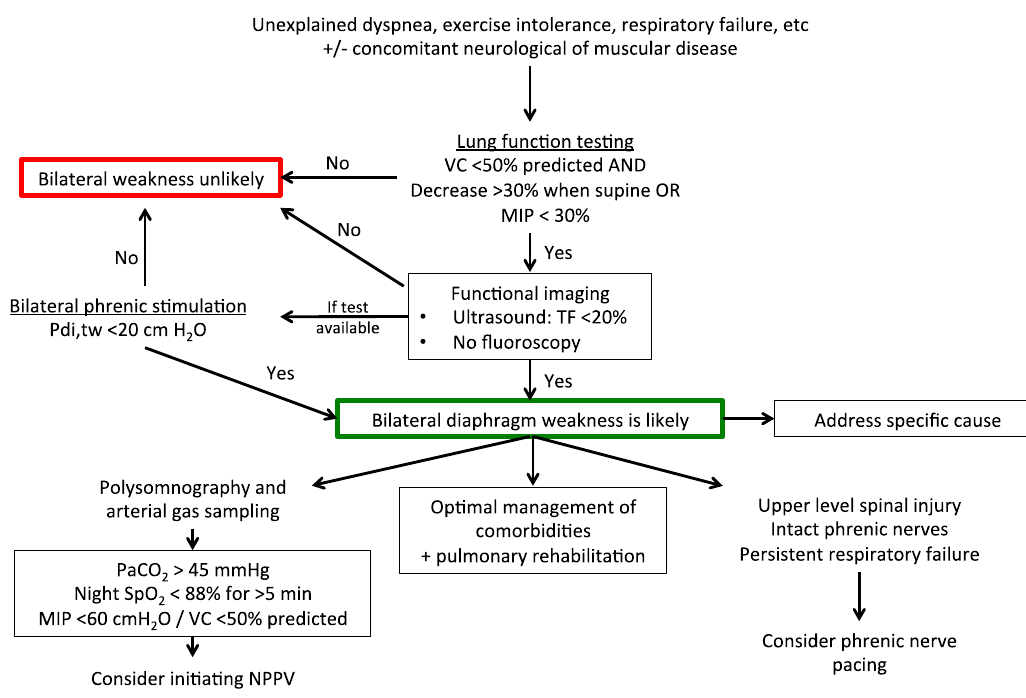
Figure 2. Suggested diagnostic and therapeutic algorithm for bilateral diaphragm weakness (outside of the intensive care setting). VC, vital capacity; MIP, maximal inspiratory pressure; TF, thickening fraction of the diaphragm; NPPV, non-invasive positive pressure ventilation; PaCO 2 , arterial partial pressure of carbon dioxide; SpO 2 , peripheral oxygen saturation; Pdi,tw, twitch transdiaphragmatic pressure.